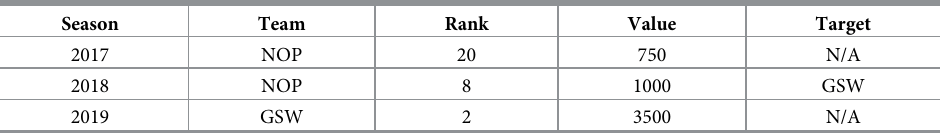
Table 6. Three years of collected team data for a representative basketball